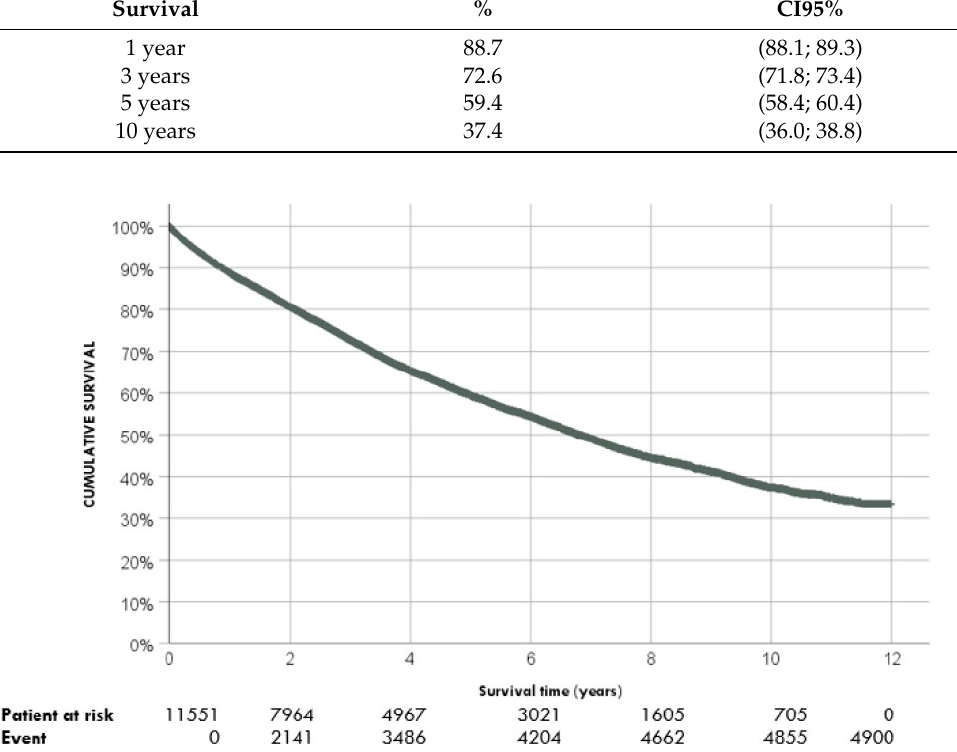
Figure 1. Global survival of renal replacement therapy. Table 2. Survival of incident patient in RRT.